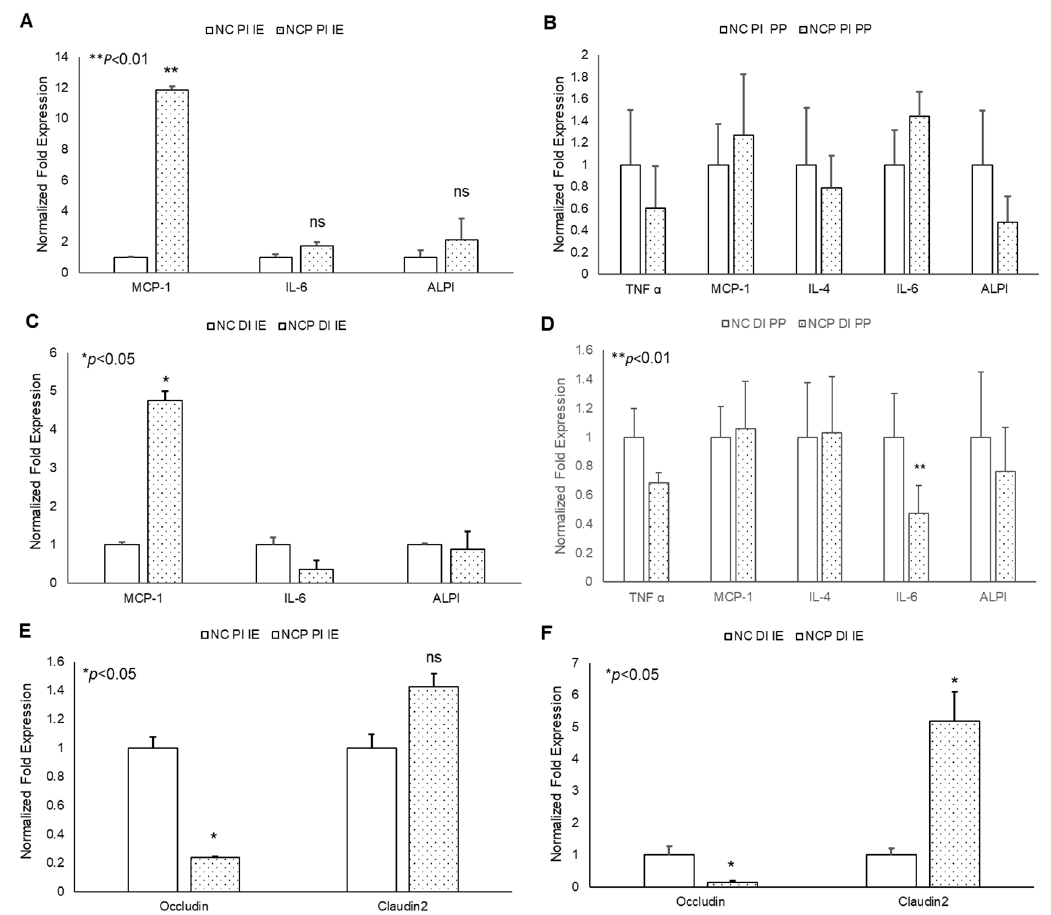
Figure 5. Chronic effects of 13-HPODE on murine proximal and distal IE and PP. For chronic studies, mice were fed with normal diet (NC) or a diet containing 4 mg/kg/mouse 13-HPODE (NCP) for one month followed by overnight fasting and euthanasia. Following sacrifice, the small intestine was collected, proximal (PI) and distal (DI) portions were separated, the intestinal epithelium and PP’s were collected. ( A , B ) PI- ( C , D ) DI- Gene expression of pro-inflammatory, and ( E , F ) permeability markers of PI/DI were assessed by qPCR. Results are represented as mean ± SEM and significance was considered as * p < 0.05, ** p < 0.01 ns: not-significant. TNF- α , Tumor necrosis factor alpha; MCP-1, Monocyte chemoattractant protein-1; IL, Interleukin; ALPI, Intestinal alkaline phosphatase; PI, Proximal intestine; DI, Distal intestine; IE, intestinal epithelial tissue; PP, Peyer’s patches; NC, Normal chow; NCP, Normal chow supplemented with peroxidized fat.